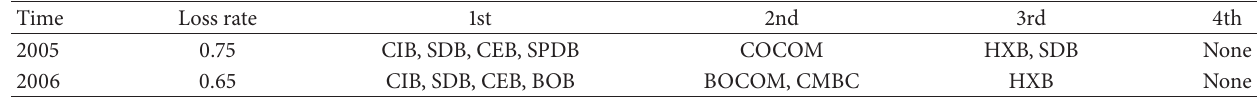
Table 4: ABC as the source of risk